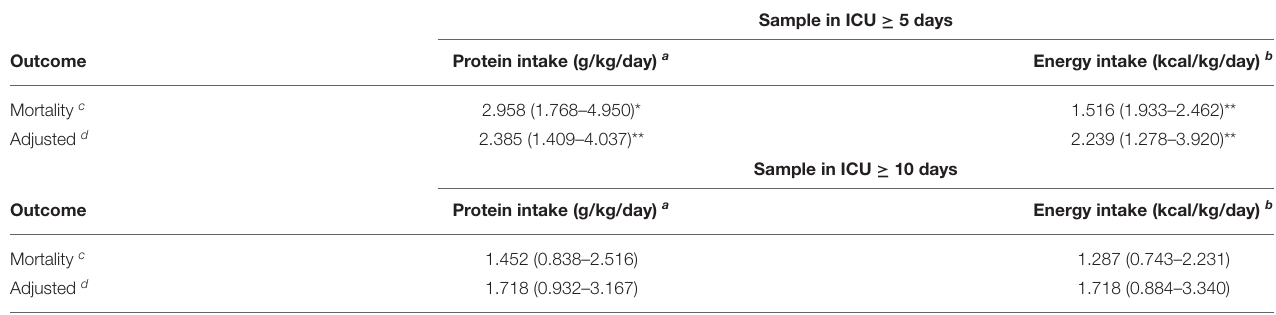
TABLE 2 | Protein and energy intake as a predictor of in-hospital mortality in critically ill patients with